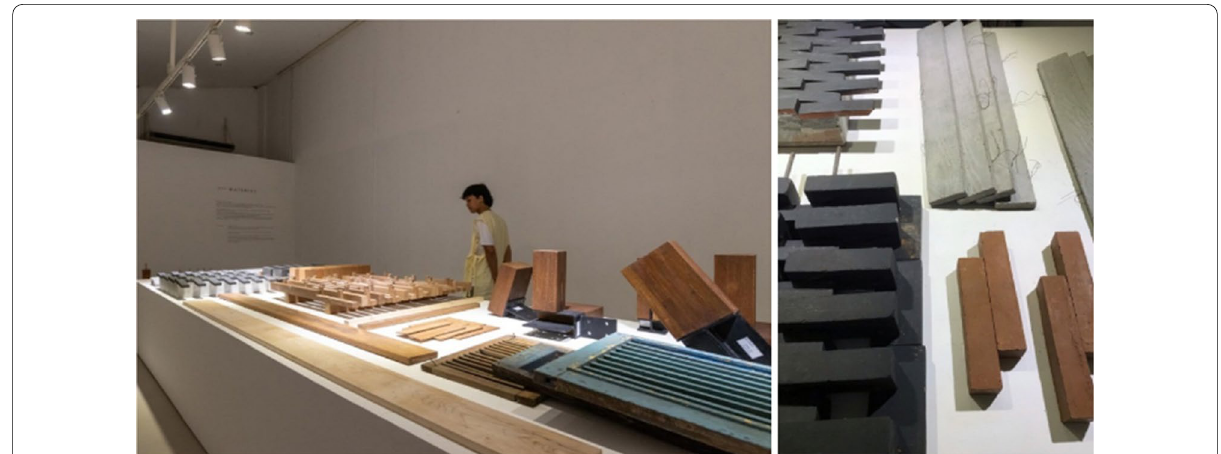
Fig. 5 Questioning Indonesian Architecture Materials at Andra Martin Prihal Exhibition. Source: https:// www. archi fy. com/ id/ archi fynow/ menga lami- arsit ektur- andra matin- lewat- pamer an- prihal and on March 28,